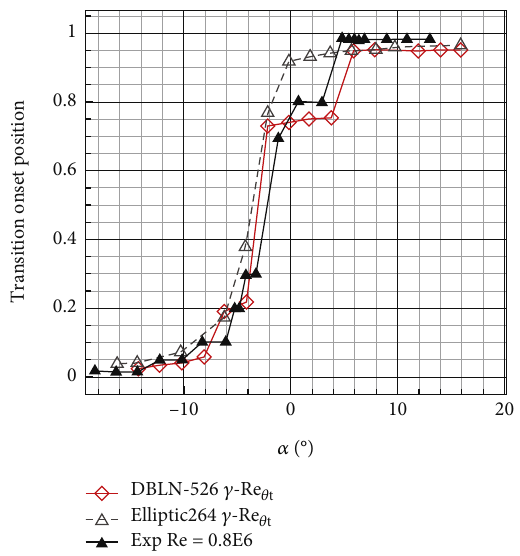
Figure 13: Pressure distribution ( Re = 0 : 8 E 6 , α = 2 ° ).